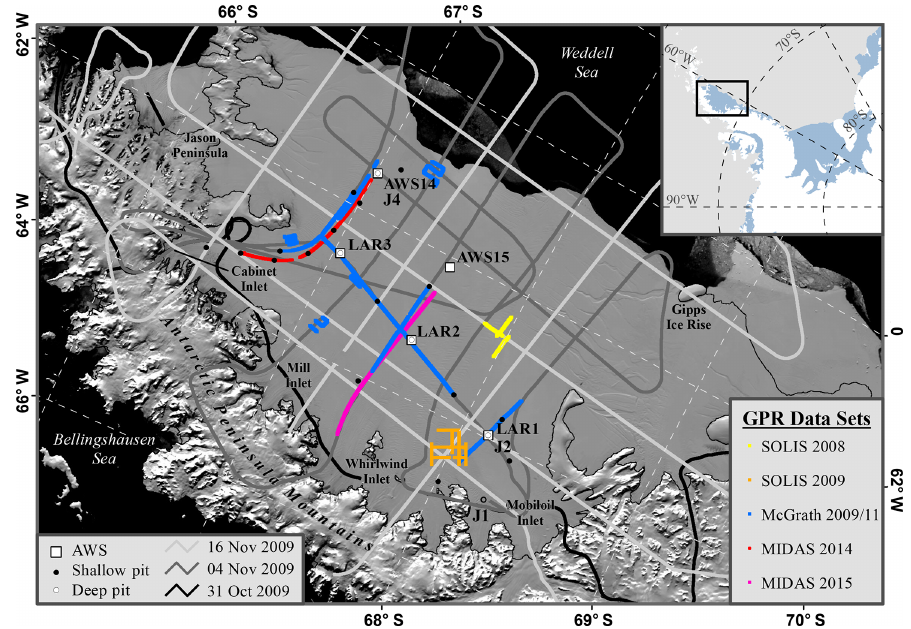
Figure 1. Map showing fieldwork locations, Operation IceBridge flight lines, GPR tracks, and relevant geographical names. The MODIS mosaic of Antarctica is shown in the background (Scambos et al., 2007; Haran et al.,